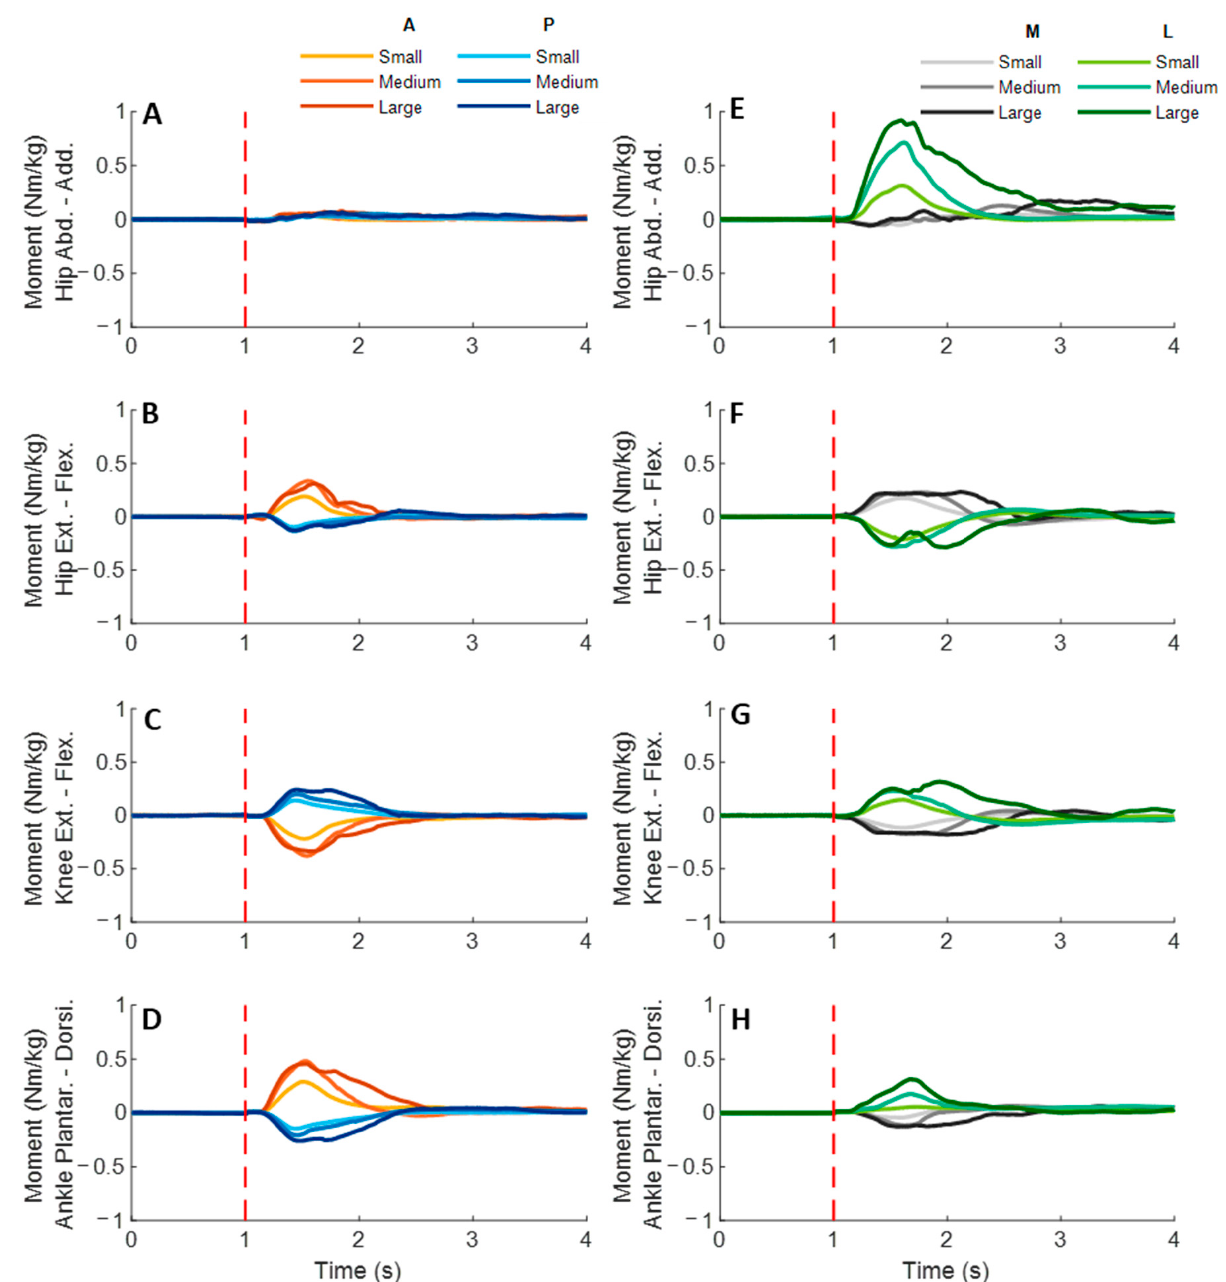
Figure 9. The mean dominant-leg joint moment changes of twelve participants following the unexpected anterior, posterior, medial, and lateral perturbations with three magnitudes ( n = 12). Mean hip adduction-abduction ( A ), hip flexion-extension ( B ), knee flexion-extension ( C ), and ankle dorsiflexion-plantarflexion ( D ) moment changes following anterior and posterior perturbations; Mean hip adduction-abduction ( E ), hip flexion-extension ( F ), knee flexion-extension ( G ), and ankle dorsiflexion-plantarflexion ( H ) moment changes following medial and lateral perturbations. (Note: The red dotted line indicated the start of pulling perturbation. Add. : adduction; Abd. : abduction; Flex. : flexion; Ext. : extension; Dorsi. : dorsiflexion; Plantar. : plantarflexion. A : anterior; P : posterior; M : medial; L : lateral).